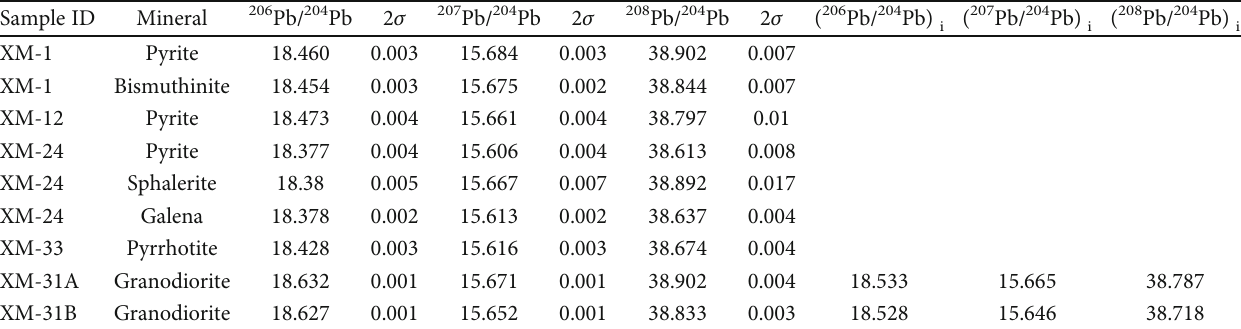
Table 3: Lead isotope data of sul fi des and granodiorite rocks from the Xinmin deposit.